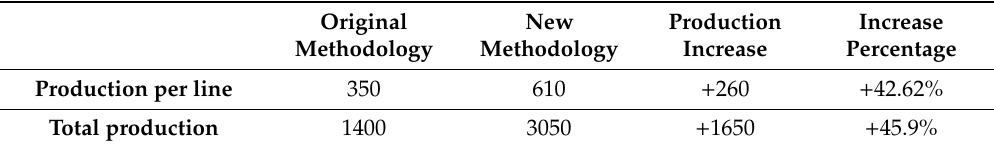
Table 11. Production increase analysis.